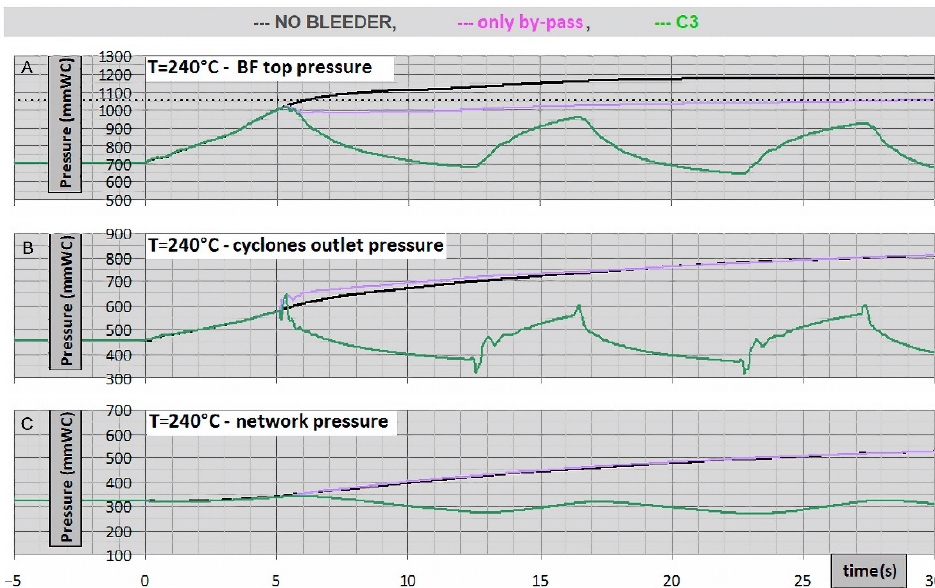
Figure 19. Evolution over time of pressure in the circuit with by-pass opening at 850 mmWC without Clean Relief Valve and C3 compared with the no bleeders case in a medium severity event. ( A ) BF top pressure; ( B ) cyclones outlet pressure; ( C ) network pressure.